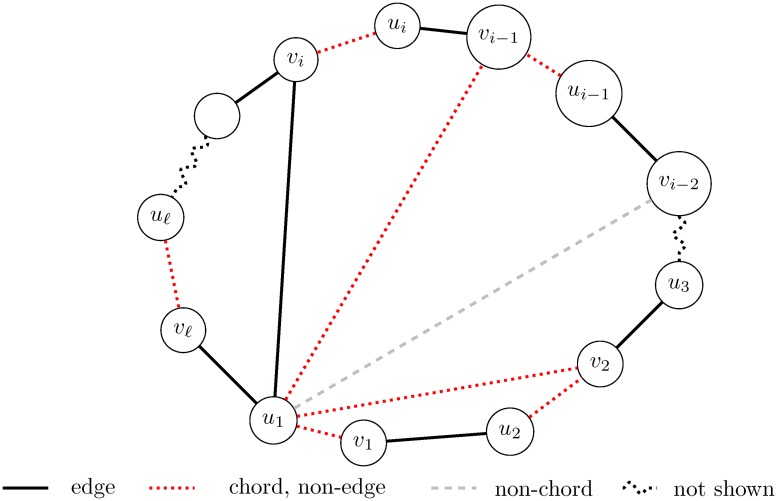
Sweeping a cycle.